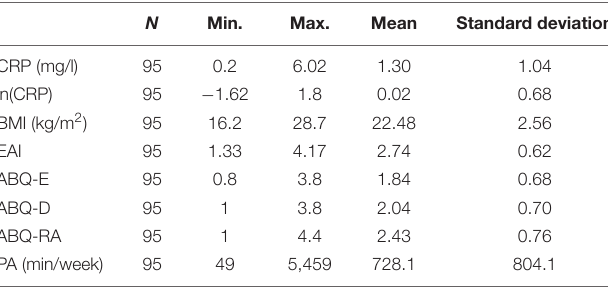
TABLE 1 | Descriptive sample statistics. TABLE 2 | Demographic data and athlete’s training